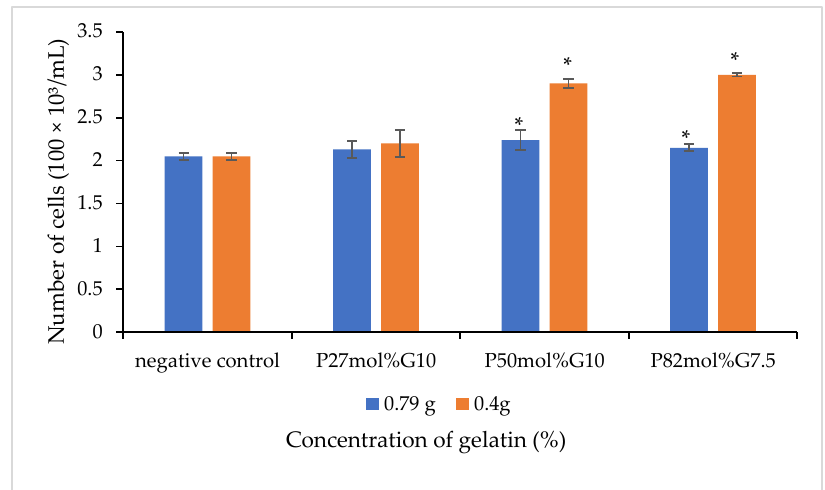
Figure 5. The cell viability of L929 cells of the various P(3HB- co -4HB)/gelatine blend scaffolds on day three for different contents of gelatin with final weights of 0.79 g and 0.4 g. Values are the mean of three replicates. Negative controls are P(3HB- co -4HB) without the incorporation of gelatine. Mean data accompanied by * asterisks represent a statistically significant difference within the group (Tukey’s HSD test, * p < 0.05).